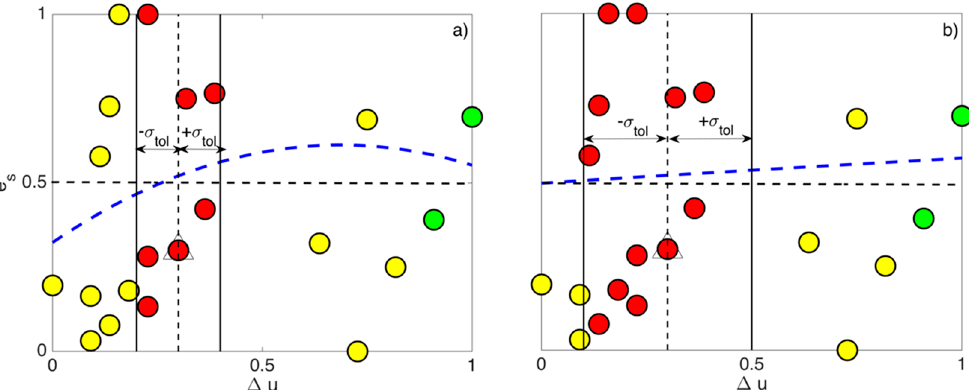
Figure 4. The effects of using of 1D DUPID algorithm to select adequate data for model construction for different values of σ tol : ( a ) σ tol = 0.1 and ( b ) σ tol = 0.2. The blue dashed lines in ( a , b ) are the obtained quadratic fits. The last point fed to the algorithm is marked with a triangle. The collected data used for testing consist of 20 random integer points drawn on the interval [ 0,50 ] for ∆ u and [ − 70,70 ] for e s . The data are normalized before it is fed to the algorithm. The black dashed line is zero error axis mapped in the normalized search